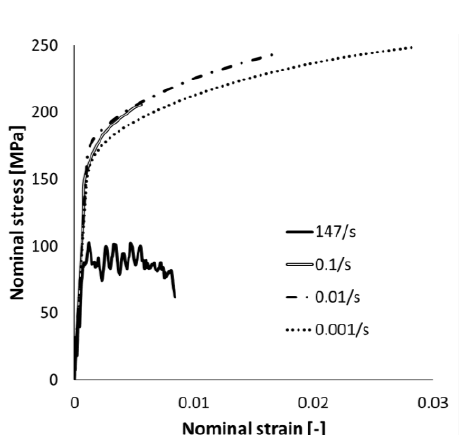
Fig. 1 Geometry of Fig. 2 Apparatus near the specimen for specimen for an impact test tensile test